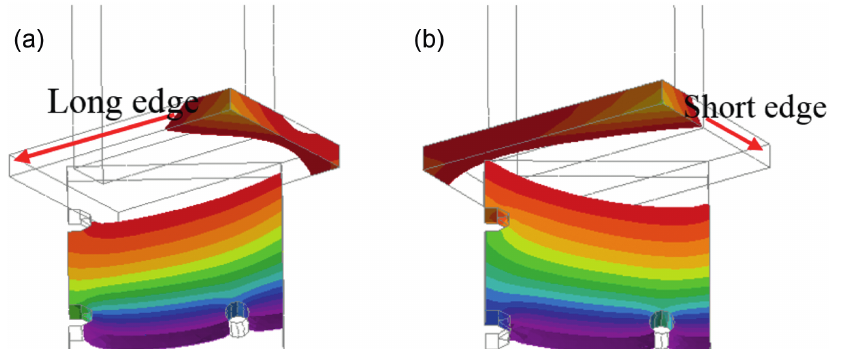
Figure 9: Solidification sequence around platform of sample (a) Cluster A (0°) and (b) Cluster C (90°), depicted by the con- tour of simulation